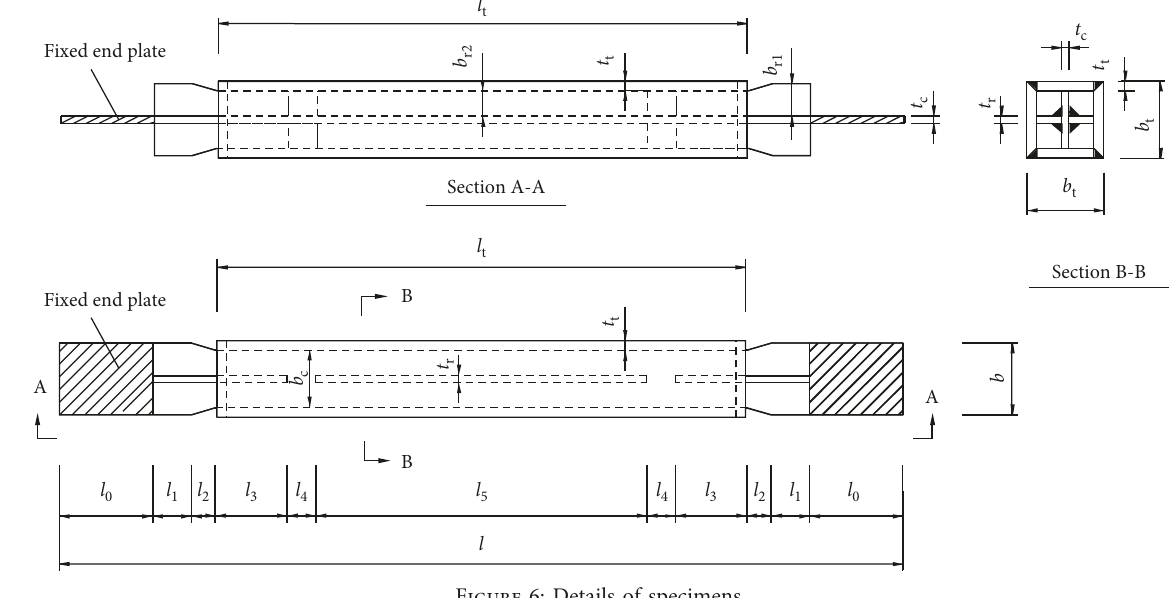
Figure 6: Details of specimens. Table 1: Geometric parameters of specimens (length unit: mm).